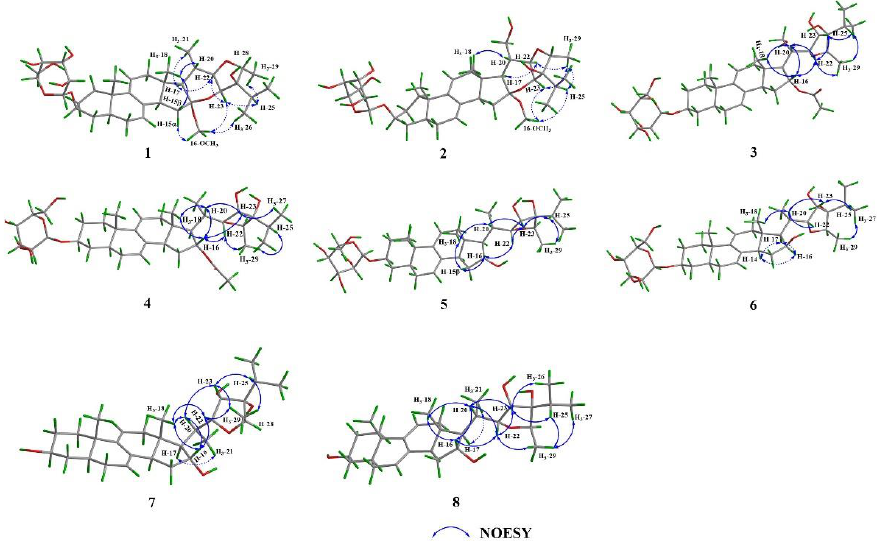
Figure 3. Key NOESY correlations of compounds 1 – 8 .